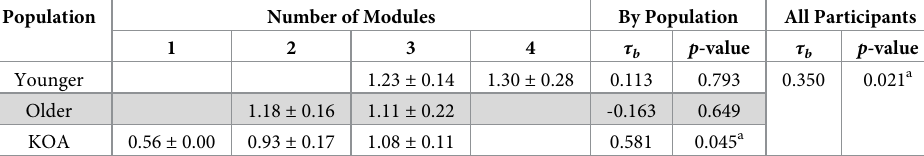
Abbreviations: τ